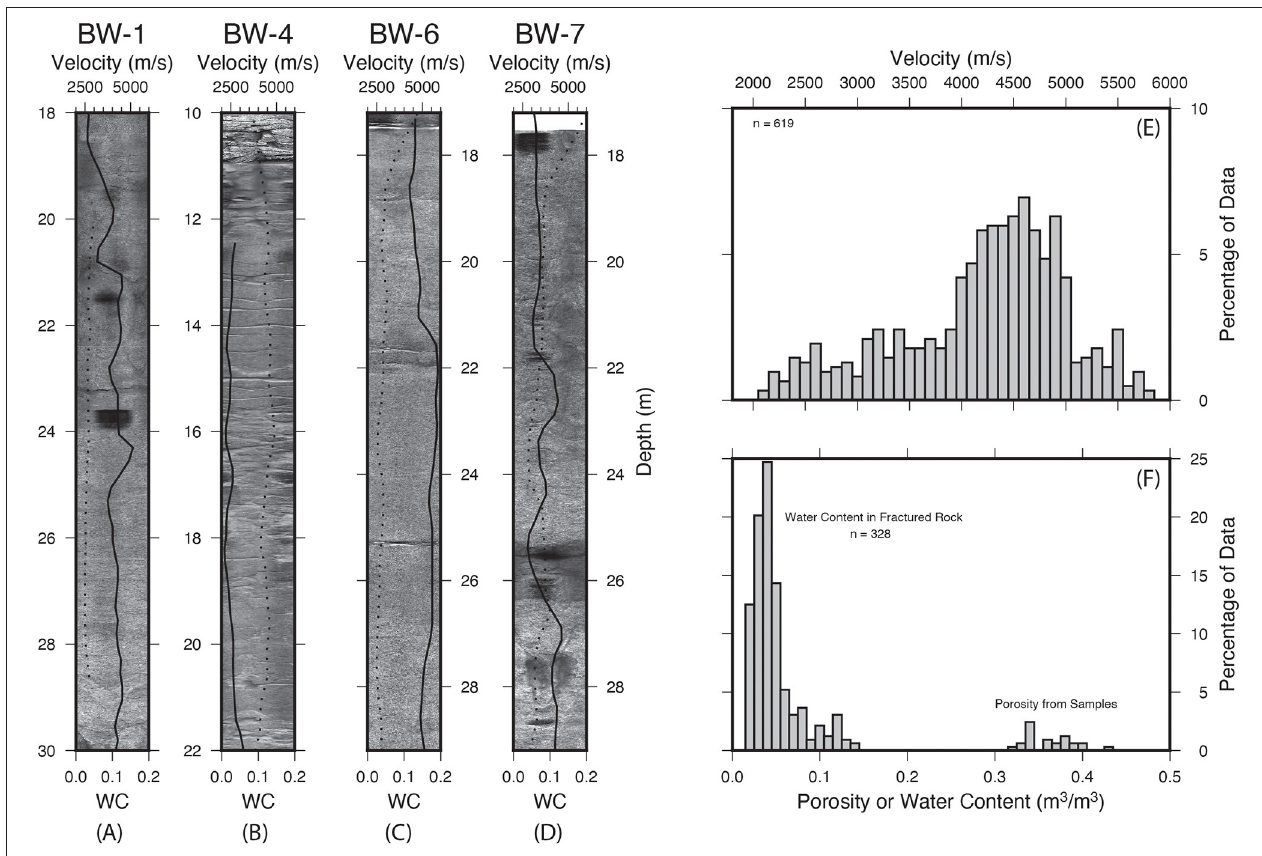
FIGURE 5 | Observations of lateral heterogeneity in the fractured rock of the CZ at the study site. (A–D) Optical televiewer logs from the top 12 meter immediately below casing. The images were converted to black and white, and the contrast was boosted to emphasize the differences in fracture density. The dotted line are the maximum water contents reported by Flinchum et al. (2018a). The solid black line is the P-wave sonic velocity. When the velocity is higher, the water content is lower. (A) BW-1 (B) BW-4 (C) BW-6, and (D) BW-7 (E) Histogram of the P-wave velocities for the sonic logs below casing in BW-1, BW-4, BW-6, and BW-7. It is assumed that all velocities come from the fractured rock region of the CZ. Note that the average value occurs between a value of 4,000–5,000 m/s. Velocities on outcrop in the Laramie Range and Southern Sierras report between 4,000 and 4,500 m/s (Holbrook et al., 2014; Flinchum et al., 2018b). (F) Histogram distribution of water contents below casing (thus the fractured rock region) from reported by Flinchum et al. (2018a). Also included in the histogram are the 25 hand measure porosity from the saprolite reported by Flinchum et al. (2018a). Porosity in the fractured rock region is generally < 0.06 m 3 /m 3